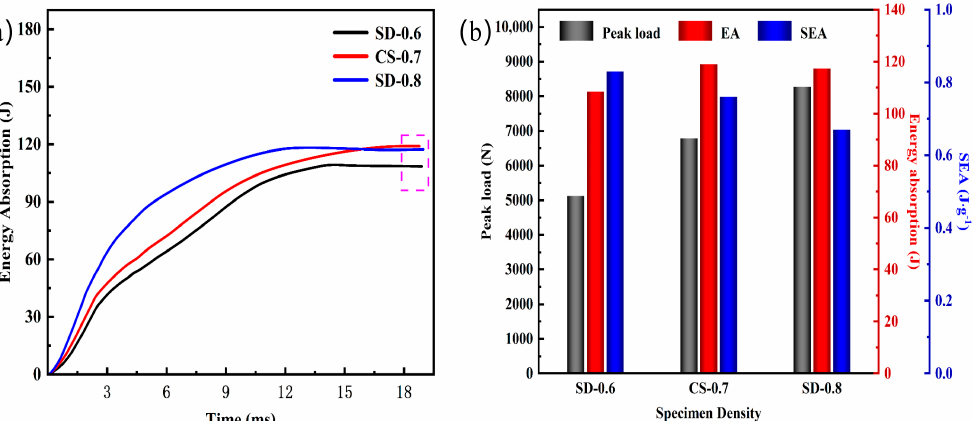
Figure 14. Evaluation of energy absorption performance at different densities: ( a ) Energy-time curves; ( b ) Comparison of structural energy absorption indicators.